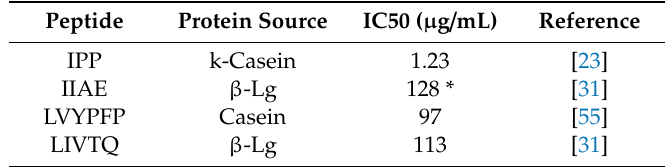
Table 5. IC 50 ( µ g / mL) value of the ACE-inhibitory peptide